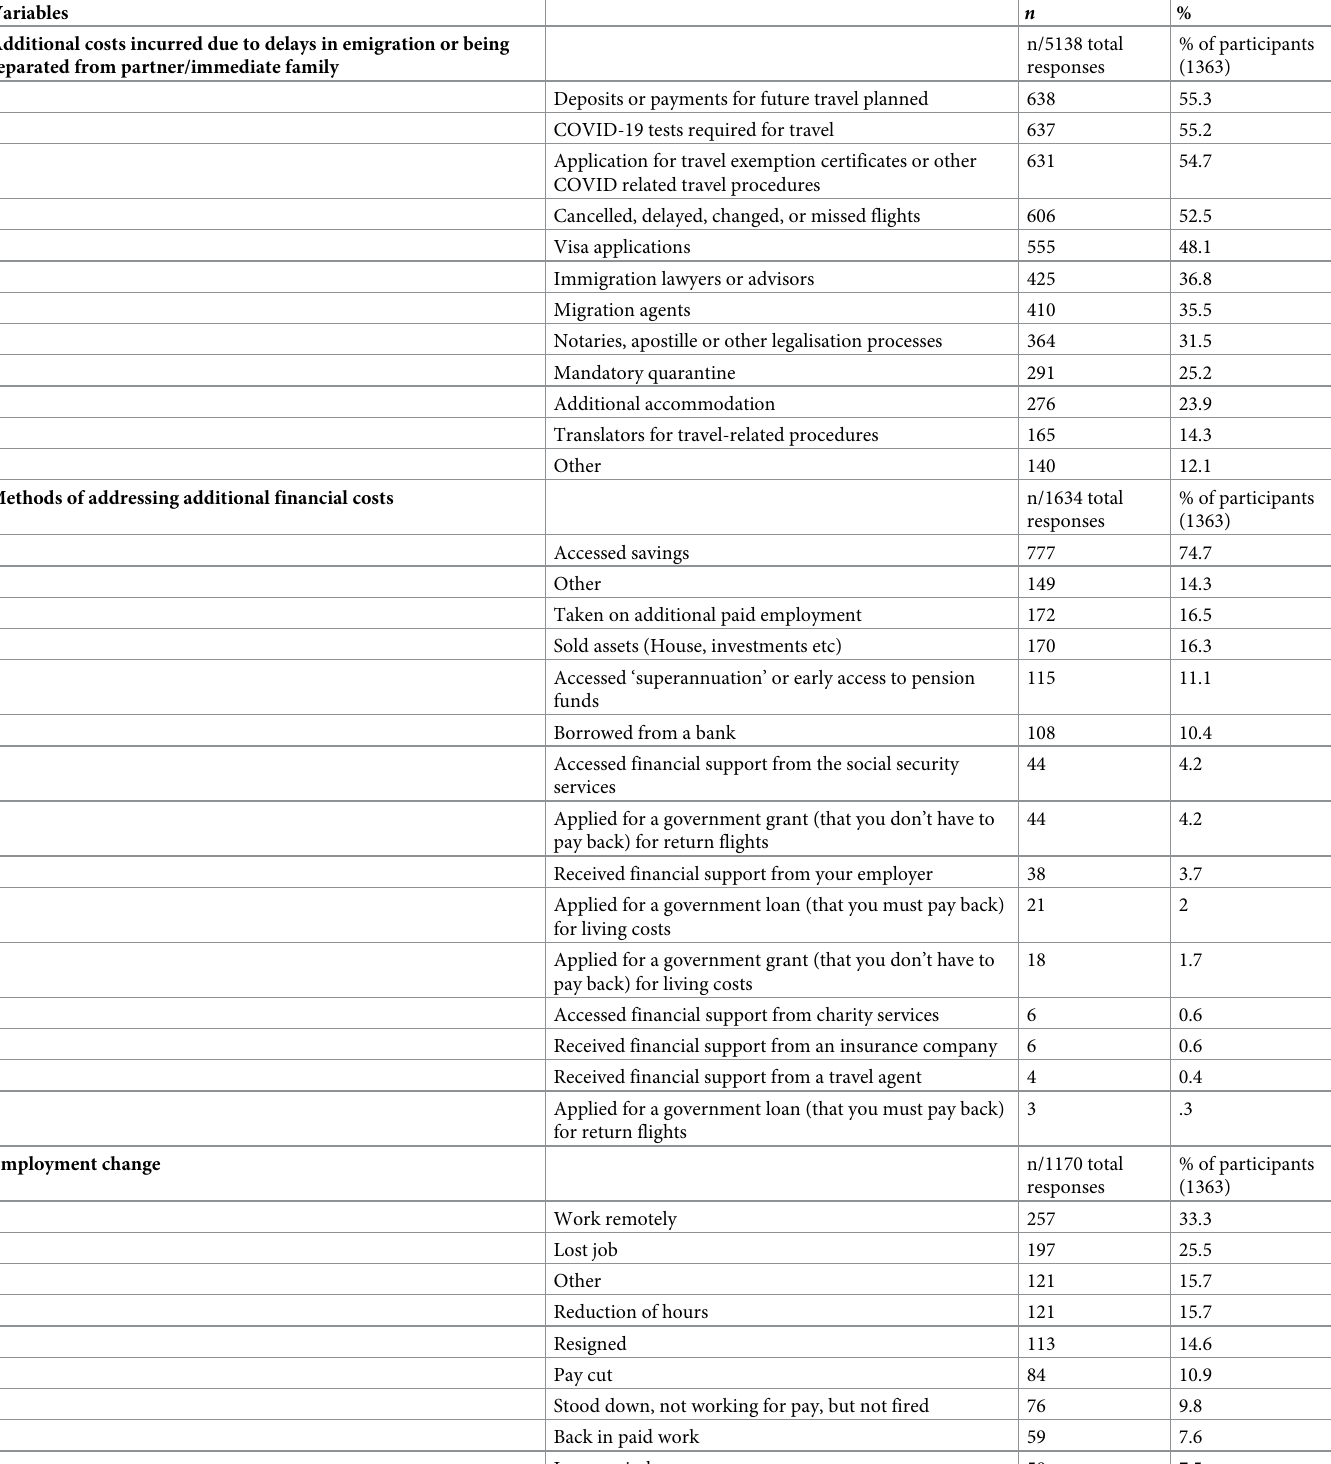
Table 5. Financial and employment characteristics of temporary visa holders unable to immigrate and those separated from their partner or immediate family dur- ing COVID-19. Variables n